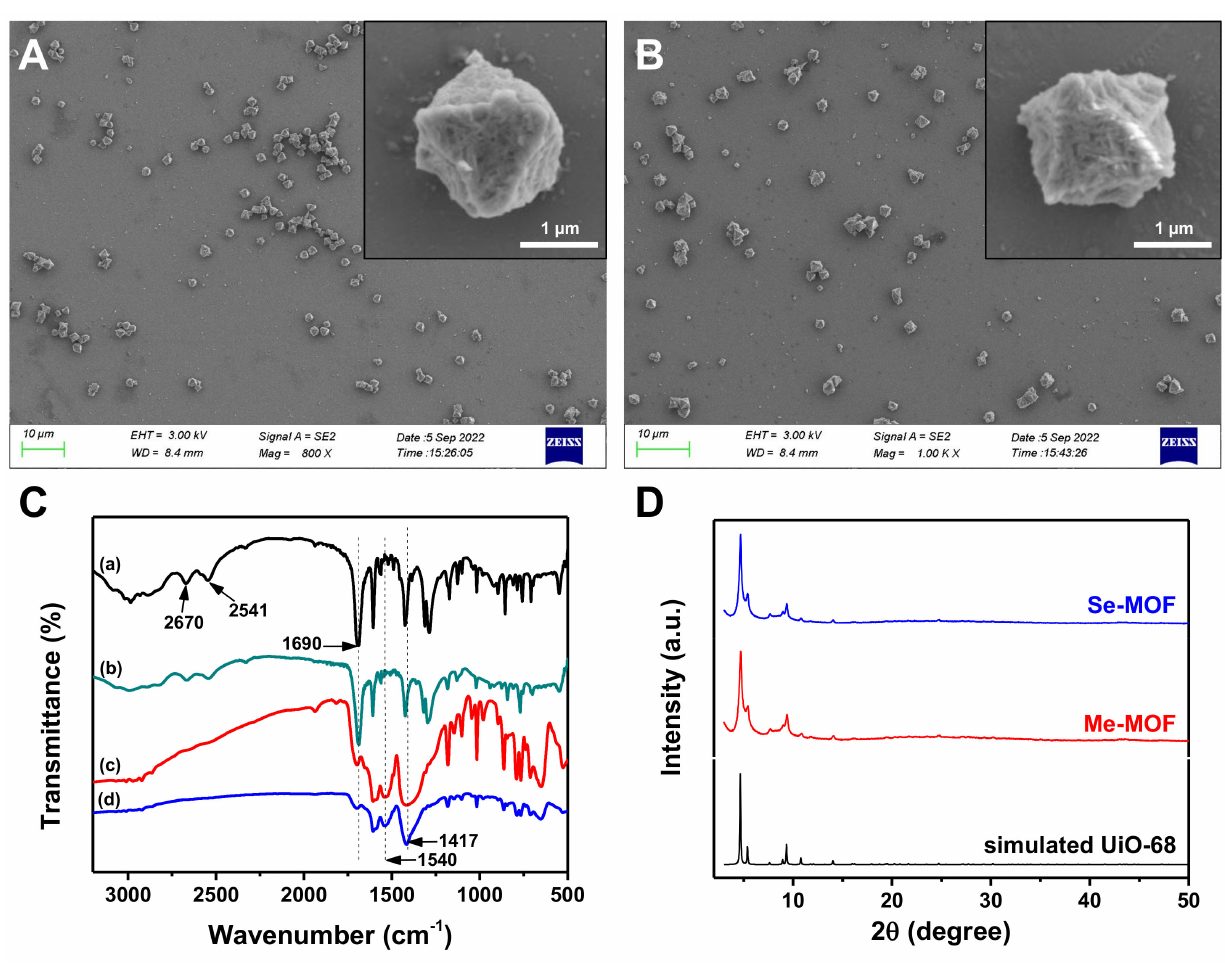
Figure 2. SEM images of ( A ) Me-MOF and ( B ) Se-MOF. ( C ) FT − IR spectra of (a) mTCDP-H2, (b) SeTPDC-H2, (c) Me-MOF, and (d) Se-MOF. ( D ) XRD patterns of the Me-MOF and